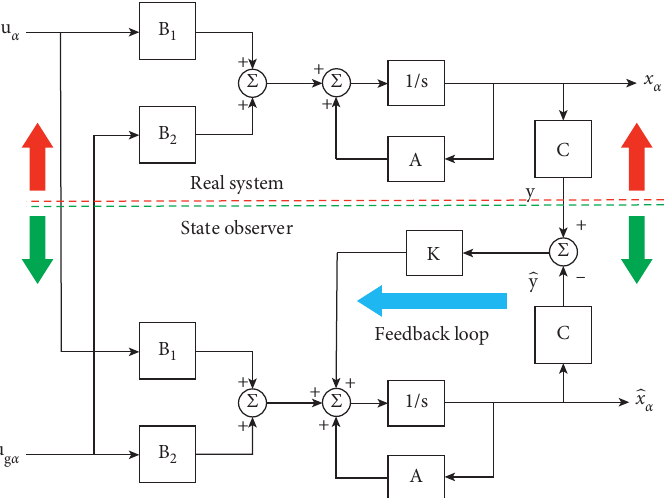
Figure 6: Structure of α -axis full-dimensional state observer.